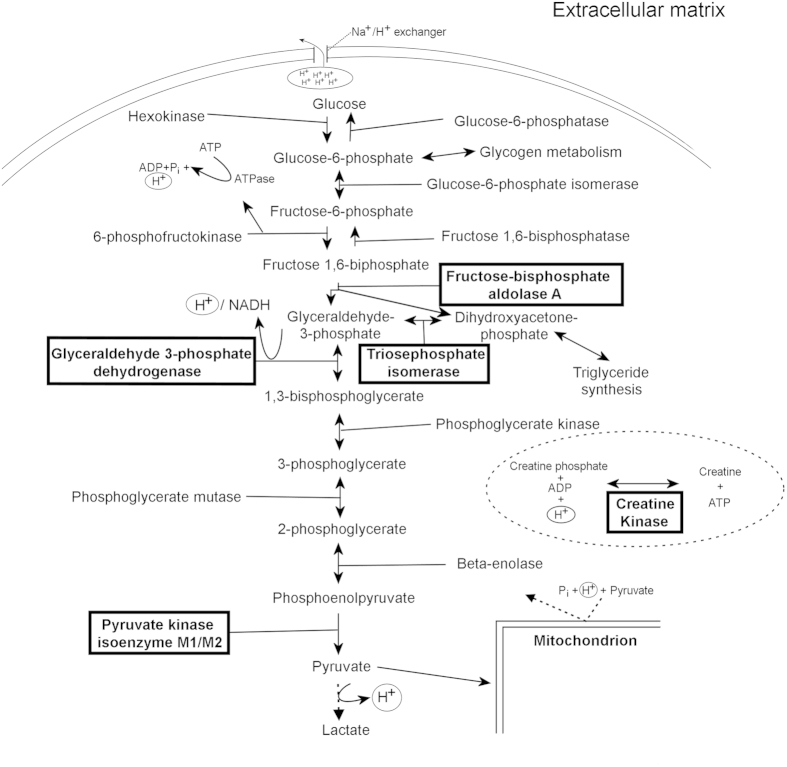
A schematic representing the metabolic pathways of the glycolysis and gluconeogenesis.The squared enzymatic proteins were all up-regulated in the CWP group compared to the healthy subjects except creatine kinase which was down-regulated. This could be explained by a higher dependence and therefore a higher strain on the glycolysis to provide energy for the skeletal muscle resulting in an accumulation of Pi, H+, pyruvate and lactate.